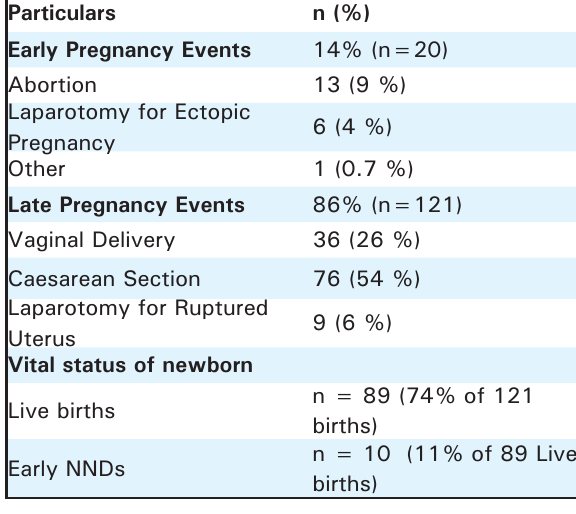
Table 5. Final mode of delivery/termination of pregnancy (n=141).